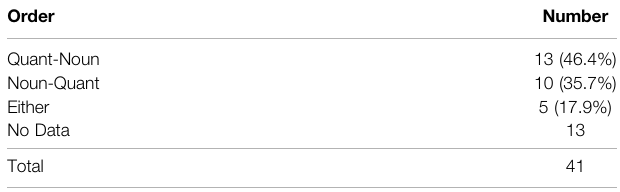
TABLE 6 | Noun/quanti fi er order in signed and spoken